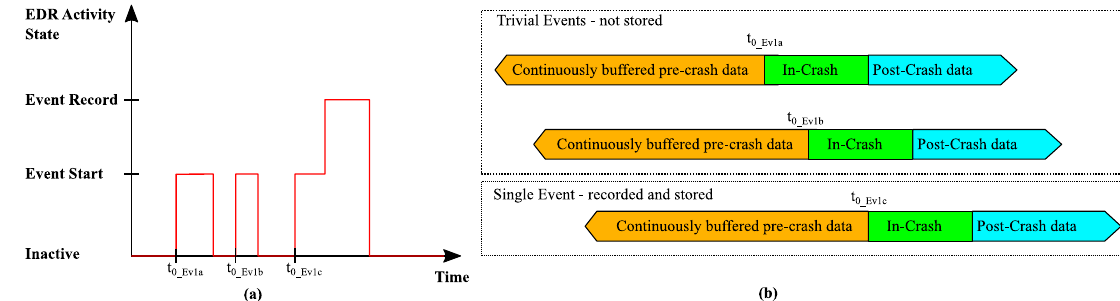
Figure 7. EDR activity states and its effect on EDR recording. ( a ) concatenated trivial events and single event; ( b ) recording scenario of these concatenated events.